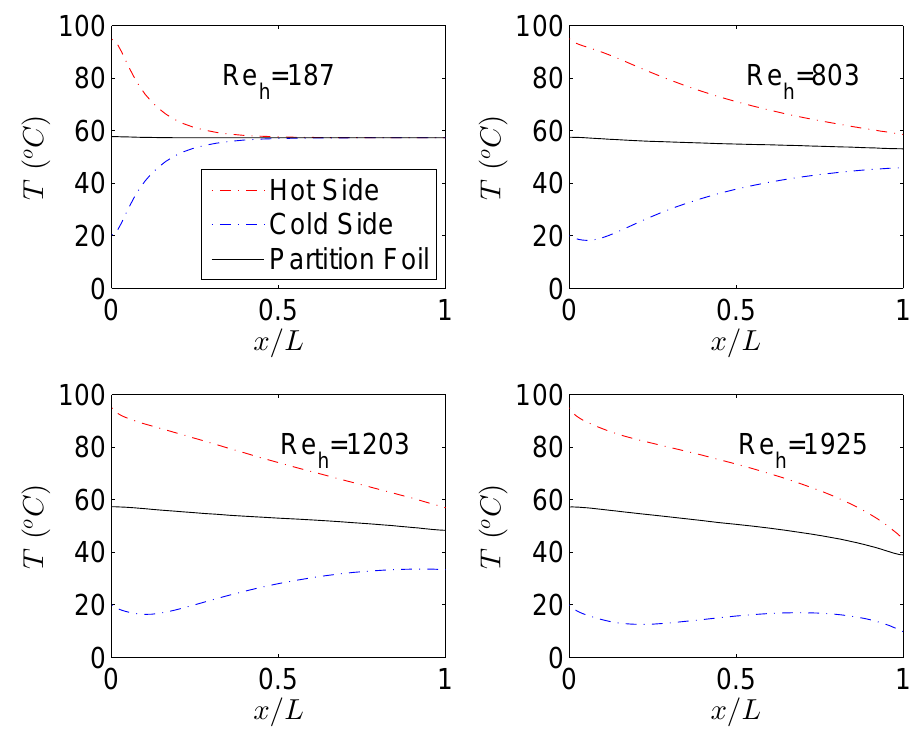
Figure 6. Temperature along the length of the hot and cold MCs for various Re in cocurrent flow